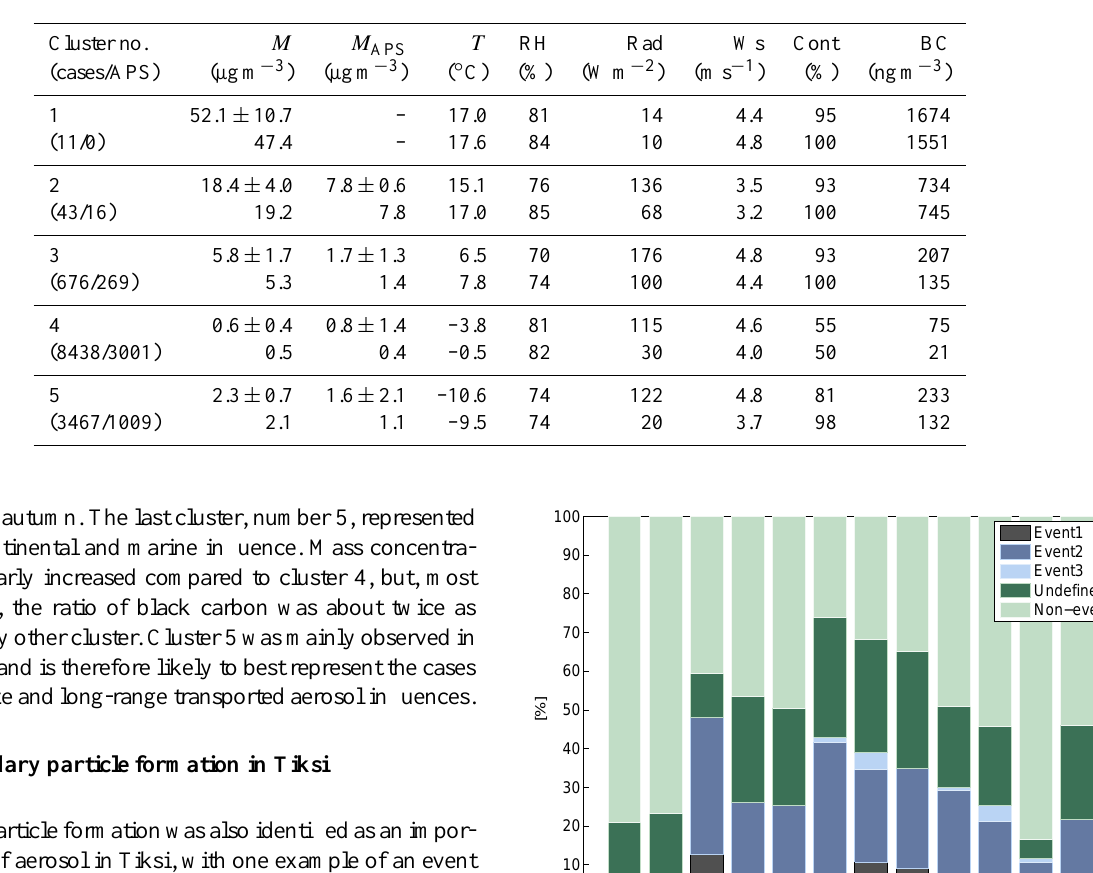
Table 3. Total particle mass concentration from DMPS data ( M ), from APS data ( M APS ), temperature ( T ), RH, solar radiation (Rad), wind speed (Ws), percentage over continental areas (Cont), and black carbon mass concentration (uncorrected) (BC) for different size distribution clusters (numbers 1–5, referring to Fig. 5b). Number of cases available for each cluster is shown in parenthesis below the cluster number, and the number of cases from APS is shown after this. For different variables, both the average (upper row) and median (lower row) are calculated, and for total number the standard deviation is also presented.